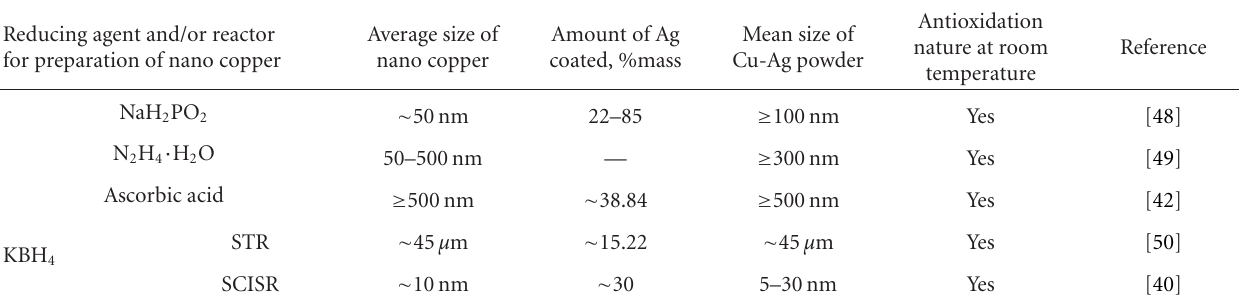
Table 4: Comparison between Cu-Ag double metal powders obtained by various processes and/or with various reactors. Reducing agent and/or reactor for preparation of nano